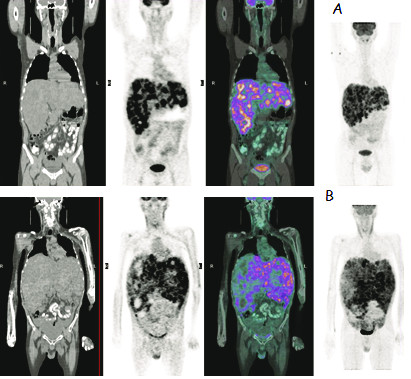
39 years-old male patient who received 1.6 GBq Y-90 microsphere therapy to the right and left lobe in separate sessions for primary hemangioendothelioma of the liver. 5A; coronal CT, 18F-FDG PET, fused and maximum intensity projection images of the whole body before the treatment. 5B; coronal CT, 18F-FDG PET, fused and maximum intensity projection images of the whole body after the treatment.